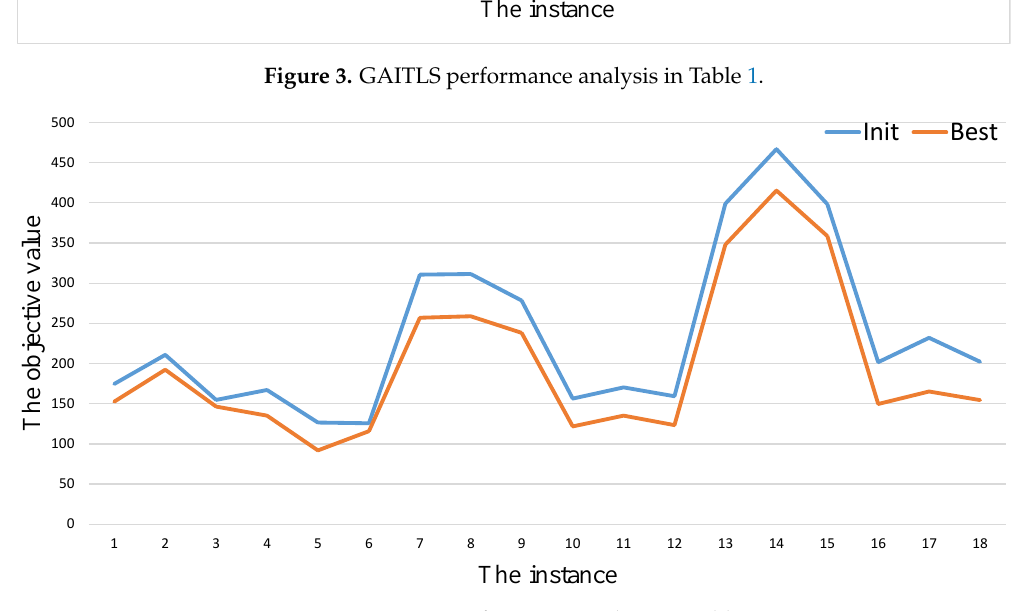
Figure 4. GAITLS performance analysis in Table 2.